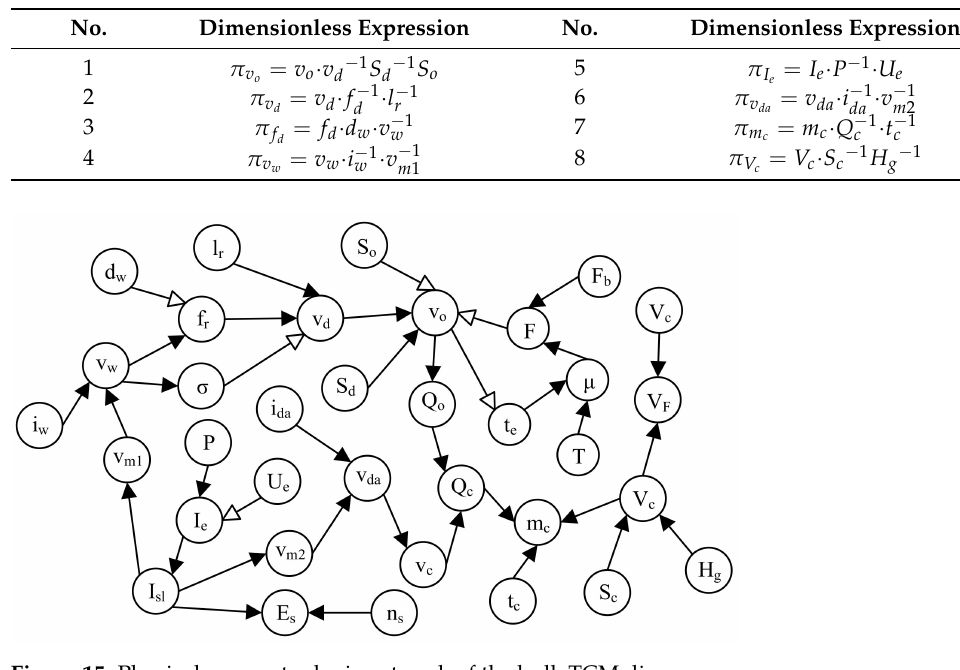
Table 7. Dimensionless expressions π of system related physical parameters.